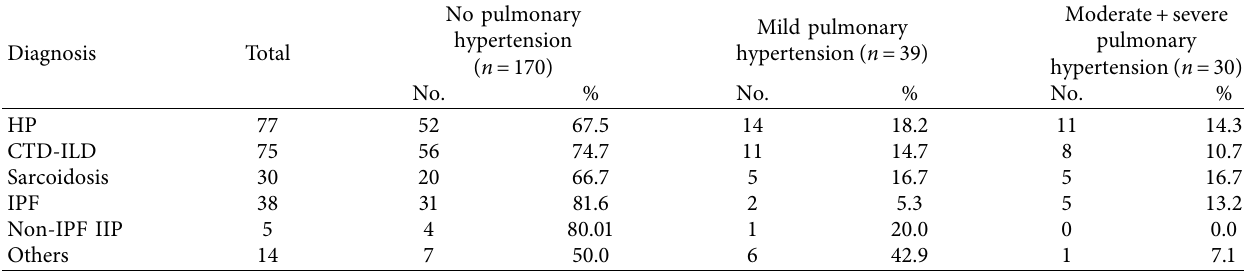
Table 5: Diagnosis-wise prevalence and severity of pulmonary hypertension (mPAP ≥ 25 mmHg). Diagnosis